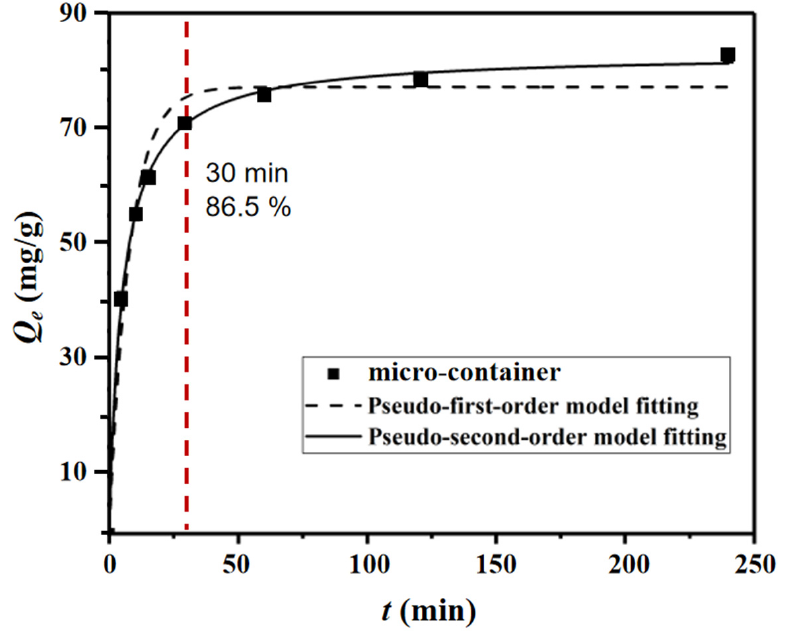
Figure 5. Kinetic data and modeling for the adsorption of uranyl ions onto micro-container.